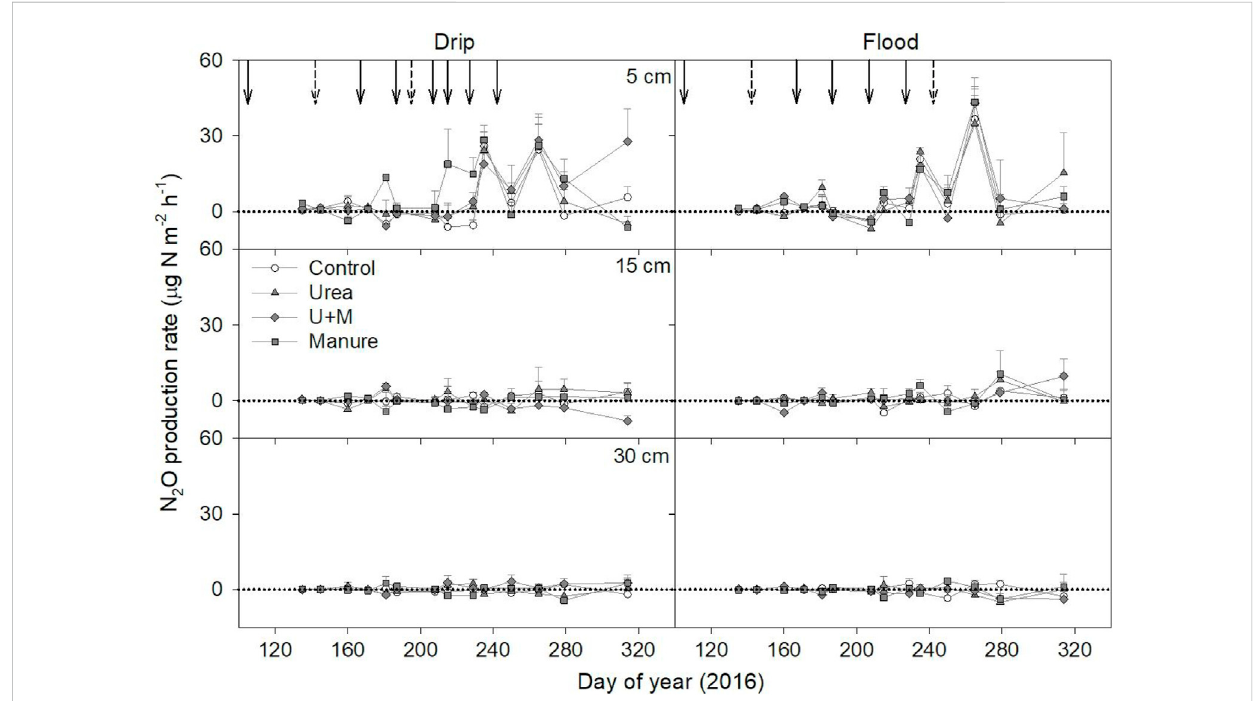
FIGURE 4 N 2 Oproductionrateateachdepthasaffectedbyfertilizertreatmentsunderdripand fl oodirrigation.Dashedarrowsindicatedatesofirrigationonly, and solid arrow indicates date of irrigation and fertigation of urea applications. Means +1 standard error ( n = 4) are presented.